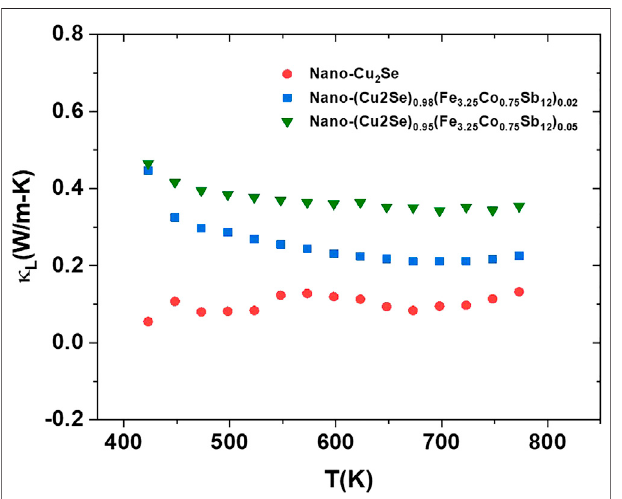
FIGURE 13 | The ZT value of samples as function of temperature for